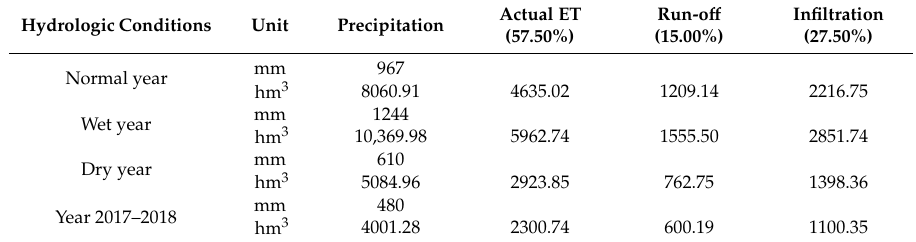
Table 1. Average annual estimations of the hydrologic cycle components in Crete on normal, wet, and dry years. Source: [14].